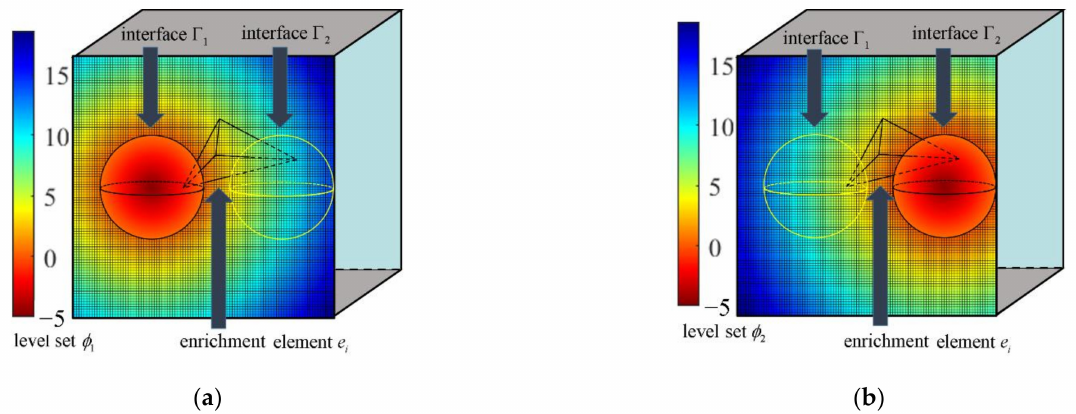
Figure 3. ( a ) The level set function of the first interface; ( b ) The level set function of the second